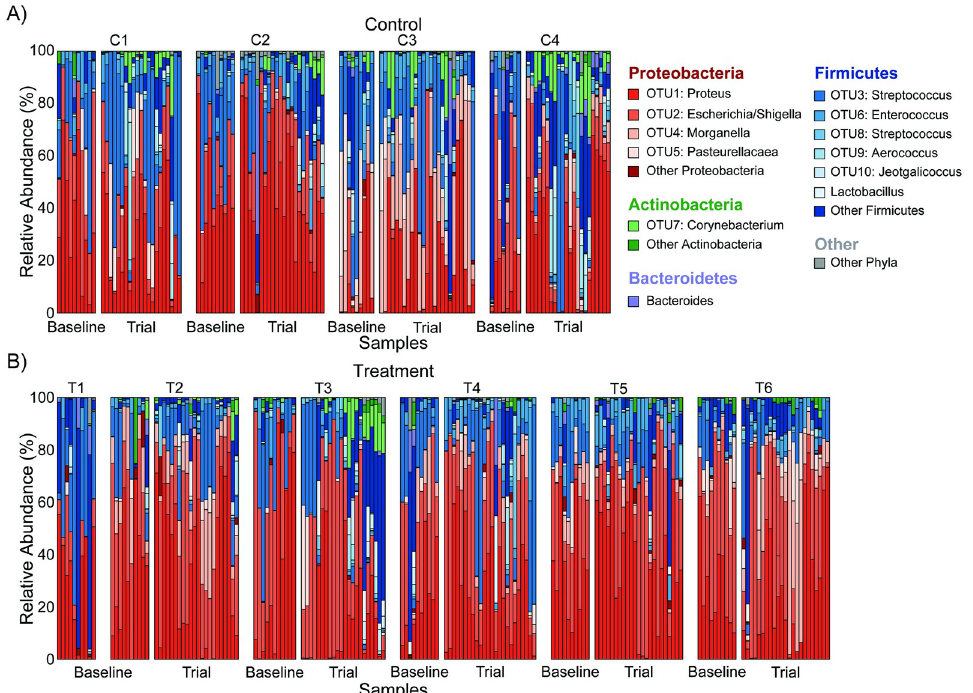
Fig 1. Community composition of Control and Treatment samples over time. Changes in relative abundance of key groups plotted over the baseline and trial periods for A) Control and B) Treatment animals.